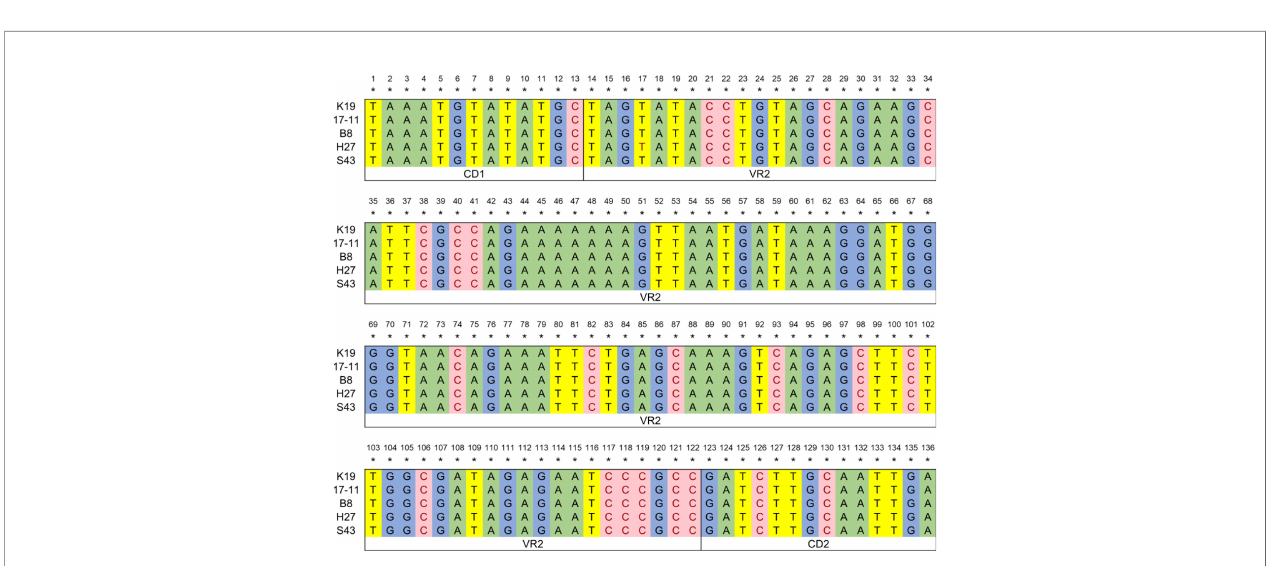
FIGURE 3 | Serotype identi fi cation of k. pneumoniae . The CD1-VR2-CD2 region of the wzc gene was ampli fi ed by PCR, sequenced and compared to determine the serotype of k. pneumoniae lysed by vB_kpnM_17-11. K19 represents the inherent sequence of CD1-VR2-CD2 region of wzc gene of k. pneumoniae serotype K19, and 17-11, B8, H27, and S43 are four strains that can be lysed by vB_kpnM_17-11 respectively.